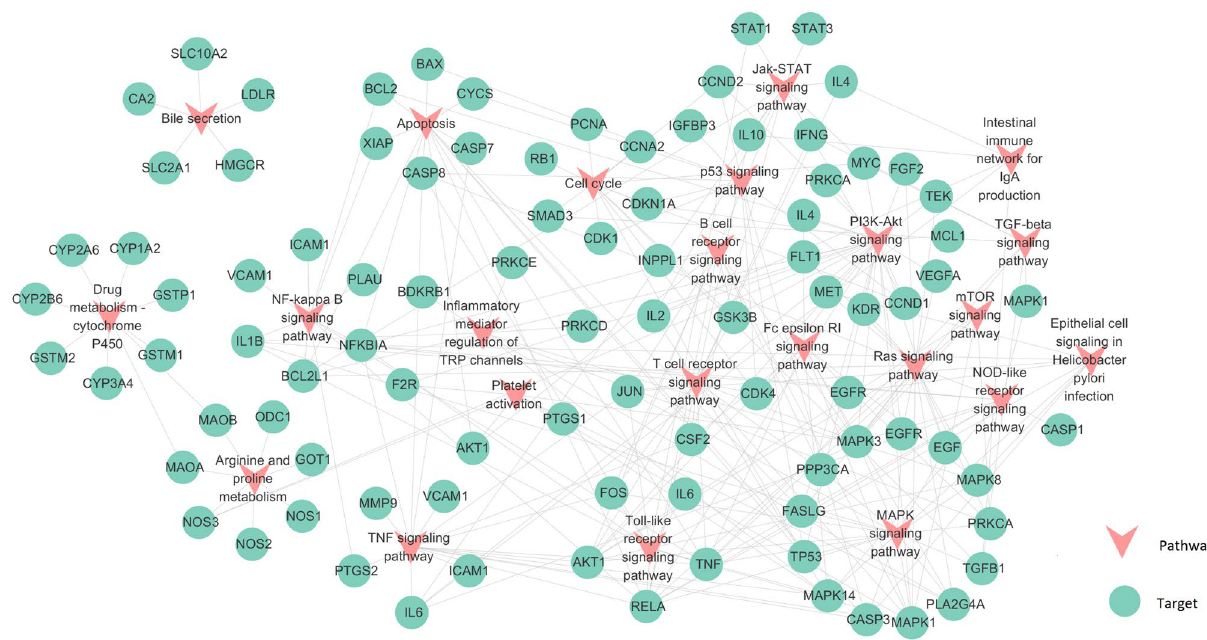
Figure 4. Target-Pathway network. The pink nodes represented pathways extracted by KEGG database which might be related to gastric cancer, the olive green circles represented targets. Gray lines represented interactions between pathways and